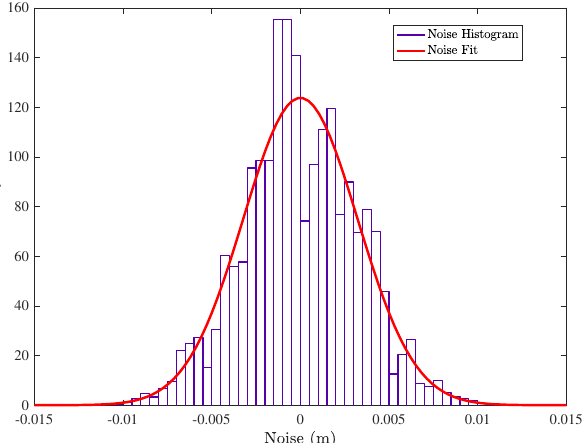
Figure 4. Histogram of the measured noise in experimentally-computed distances and normal distribution fit ( σ = 3.2